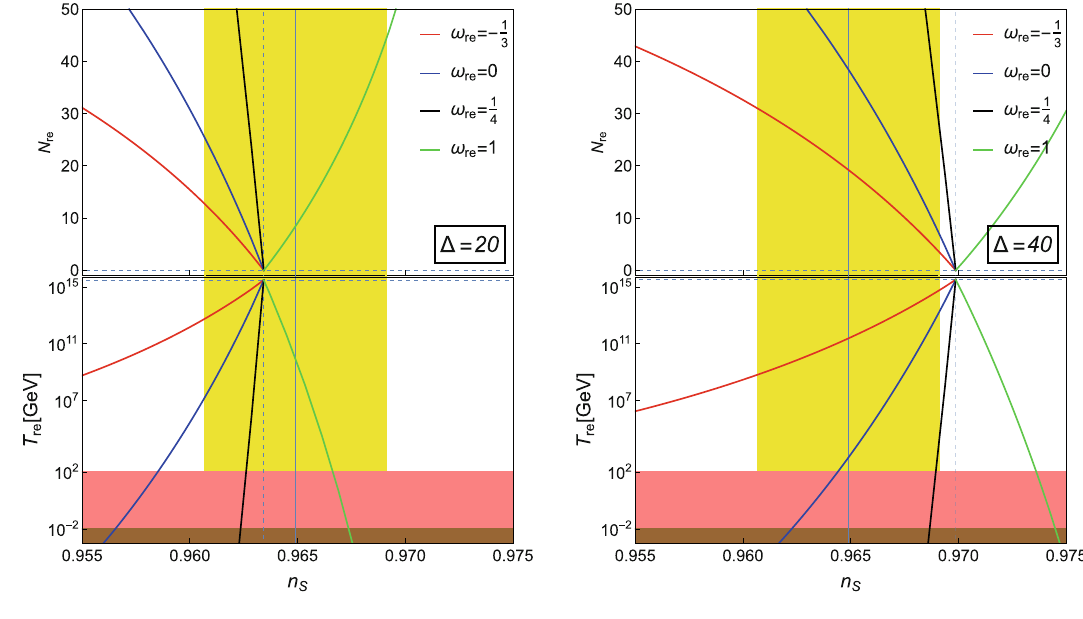
The pink and brown shaded regions indicate the T re ≤ 100GeV and T re ≤ 10MeV energy scales, respectively. The ω re values residing inside the shaded regions are